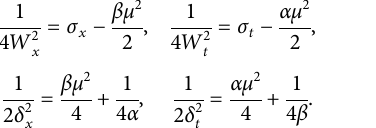
Figure 1. These parameter values corresponded to α = 3.24 cm 2 , β = 0.81 ps 2 , σ − 2 , and σ − 2 . We evaluated x = 0.2168 cm t = 0.8673 ps